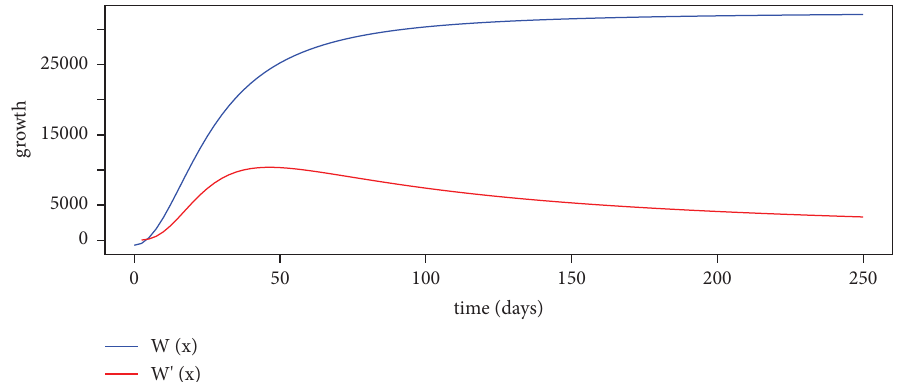
Figure 7: Weibull curve with fnal level of 300,000. Te red line shows the corresponding change curve multiplied by